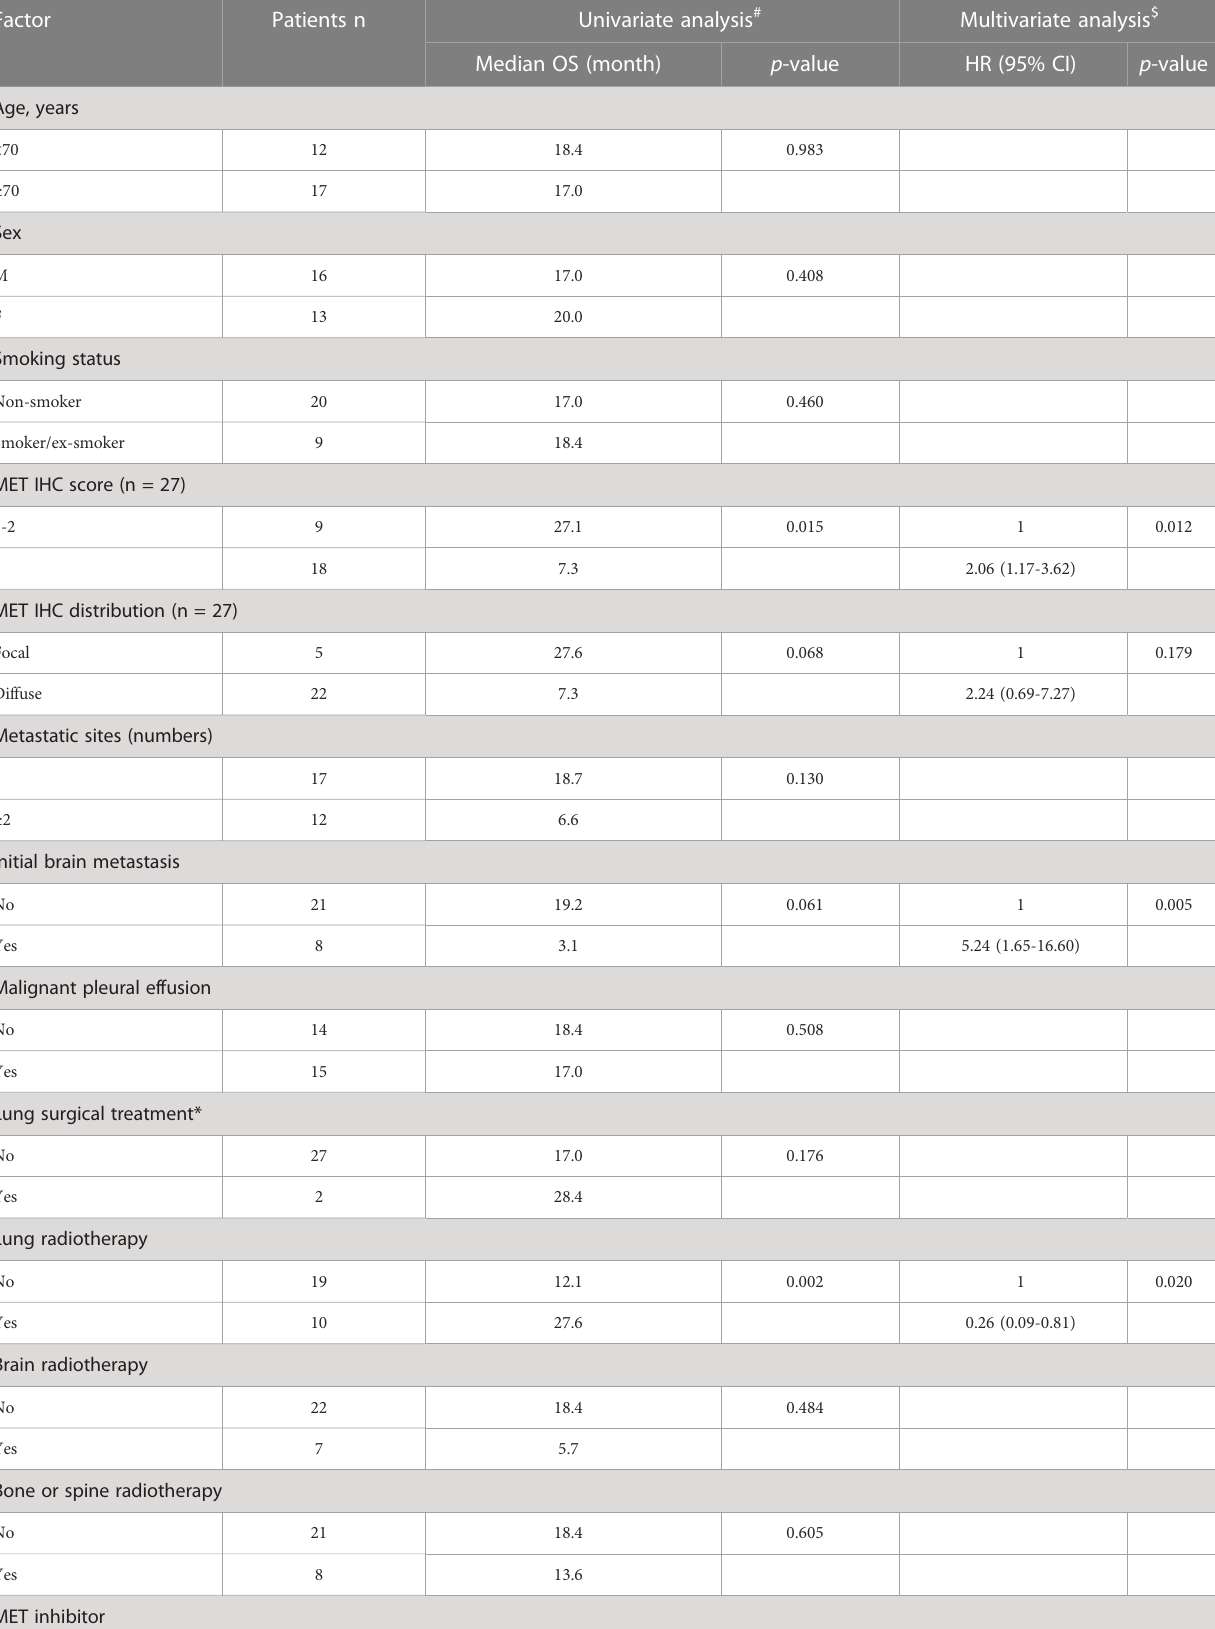
TABLE 3 Univariate and multivariate analyses of prognostic factors for overall survival in patients with stage IV MET ex14-positive adenocarcinomas who received anti-cancer treatments (n =